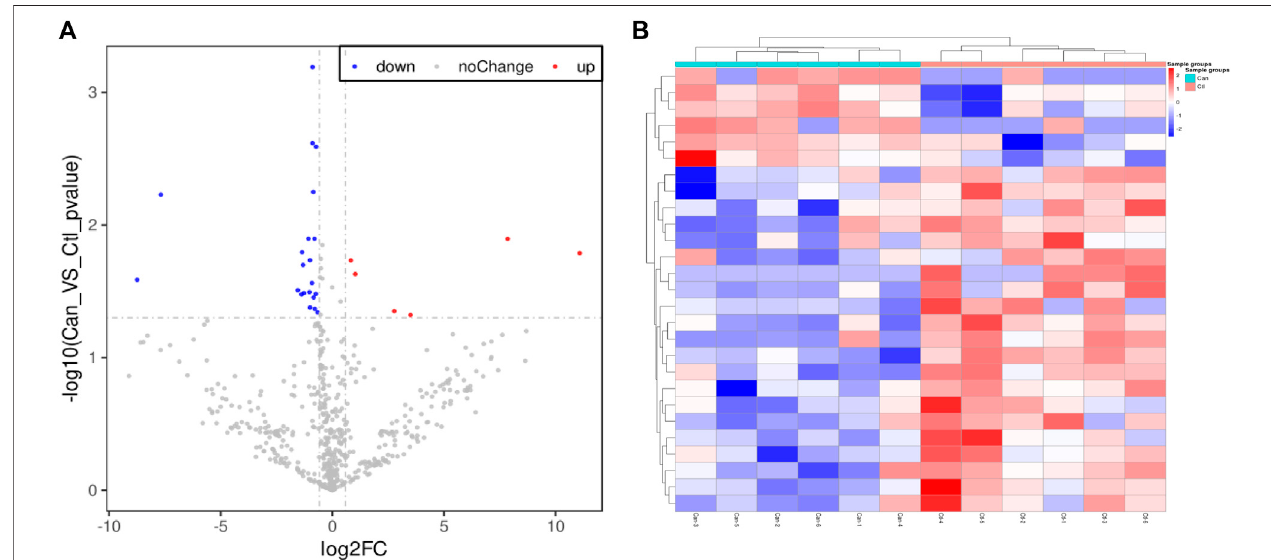
FIGURE2| VolcanoplotandClusterheatmap. (A) .Thevolcanoplotofproteomeofcancergroupandgroupofhealthyvolunteers,Atotalof27differentialproteins were identi fi ed; a total of six proteins with increased expressions and a total of 21 proteins with decreased expressions. (B) . The heatmap of proteome difference with sample clustering of cancer group and group of healthy volunteers. the abscissa are the members of “ cancer group ” and “ group of healthy volunteers ” , the ordinate are the members of 27 different expressed proteins between colorectal “ cancer group ” and “ group of healthy volunteers ” .